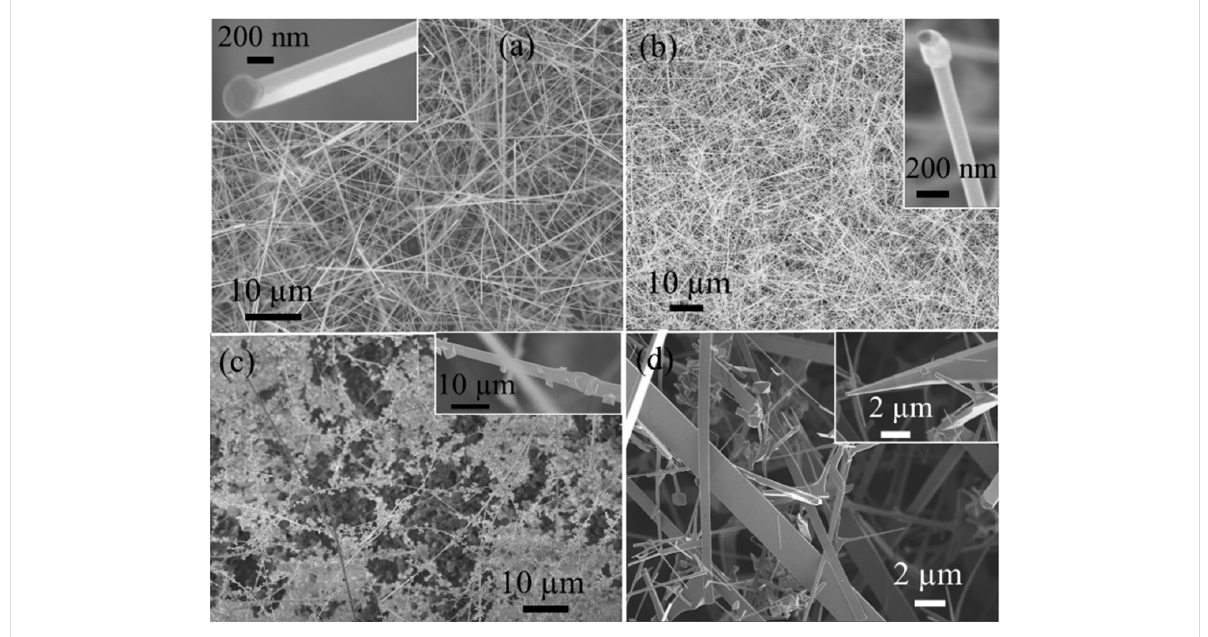
Figure 1: FESEM images of the (a) square-shaped NWs grown at 950 °C, (b) cylindrical- shaped NWs grown at 1000 °C, insets in 1a and 1b show a single NW with a Au nanoparticle at the tip, (c) flower creeper-like, self catalytically grown, belt-shaped NWs, and (d) NBs after ultra-sonication, where the inset shows a tapered